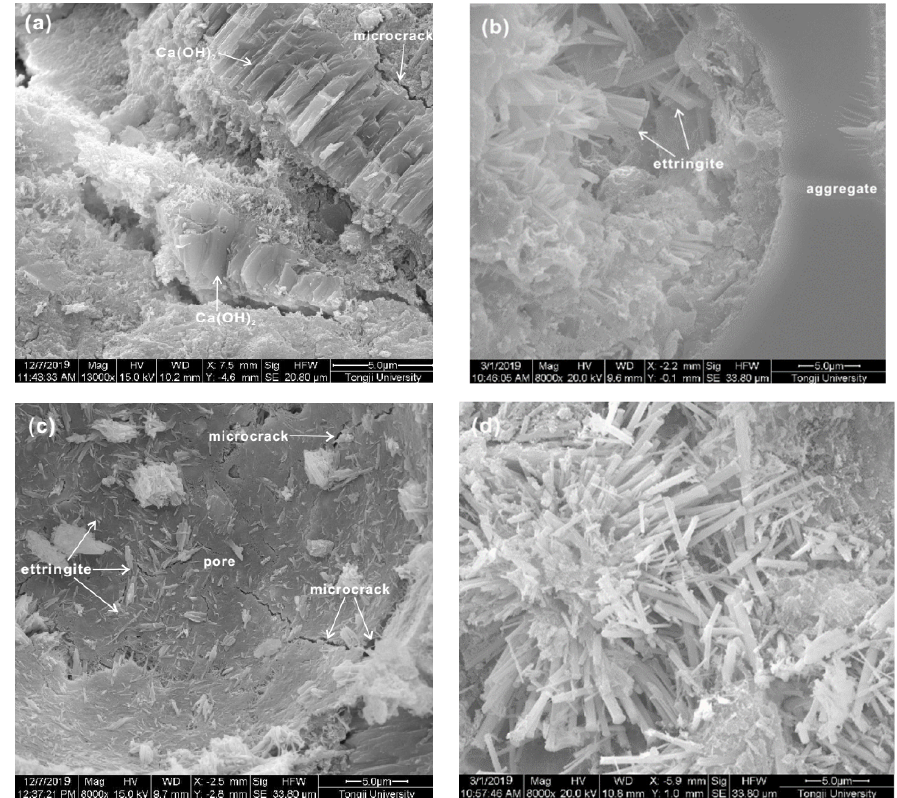
Figure 7. SEM images of FG-4550 mortars under di ff erent curing conditions. ( a , b ) FG-4550 at 3 days and 28 days under normal curing conditions; ( c , d ) FG-4550 at 3 days and 28 days under steam curing conditions.